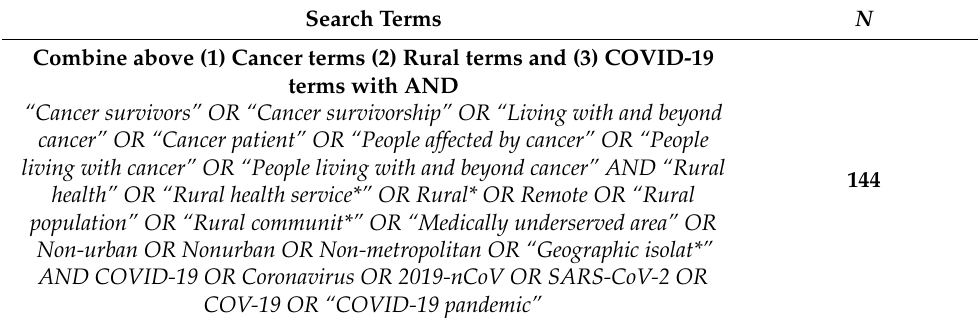
Table 1. Cont. Search Terms N